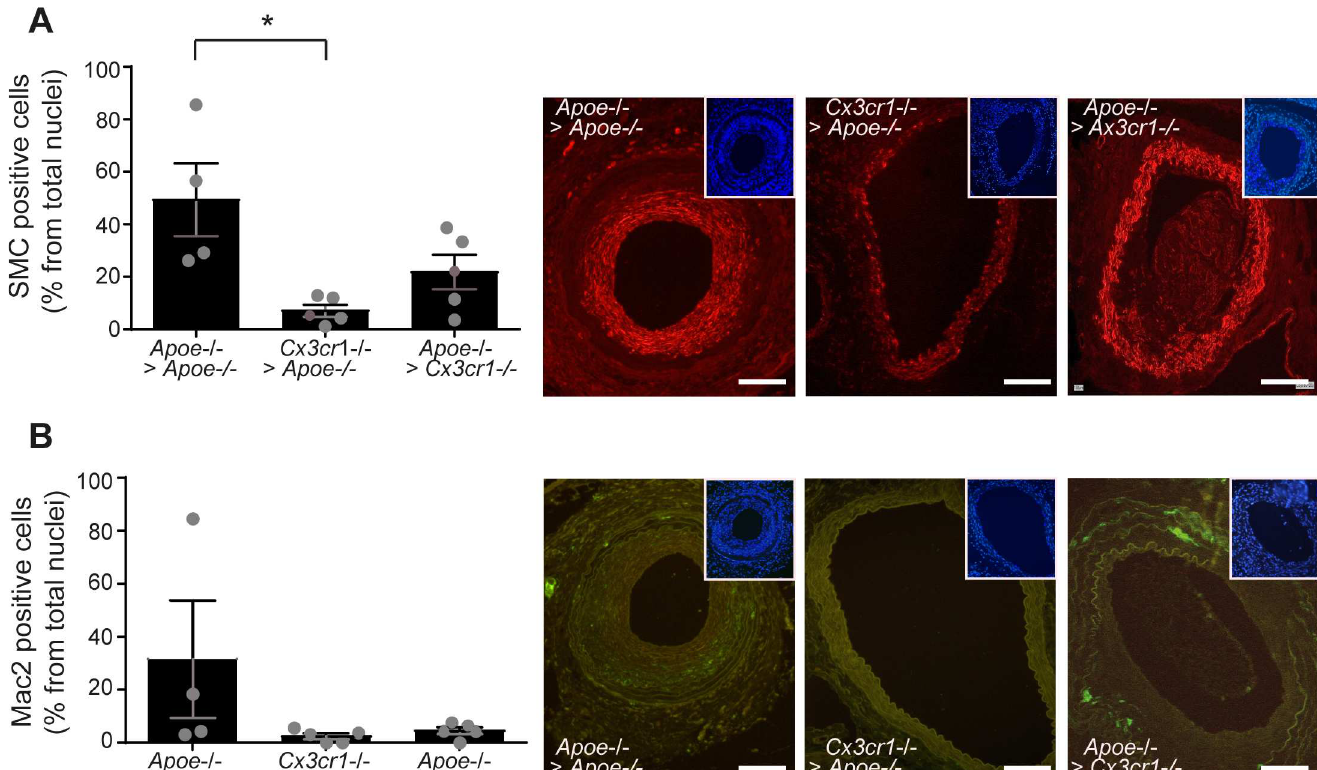
Fig 2. Reduced numbers of SMCs in transplanted Cx3cr1 -/- Apoe -/- aortic plaques. Apoe -/- mice were transplanted with Apoe -/- aortic segments (n = 4, Apoe -/- > Apoe -/- ) or Cx3cr1 -/- Apoe -/- aortic segments(n = 5, Cx3cr1 -/- > Apoe -/- ), and Cx3cr1 -/- Apoe -/- mice were transplanted with Apoe -/- aortic segments(n = 5, Apoe -/- > cx3cr 1 -/- ) and placed on a high fat diet for 4 weeks. Immunohistochemistry and quantificationof (A) SMCs (alpha-Smooth Muscle Actin staining,x20, red) and (B) macrophages (MAC2, x20, green) in plaquesof the transplanted aortic segment. Counterstaining with DAPI (blue) is showedin each images in insert. * p < 0.05,Scale bars 100 μ m.